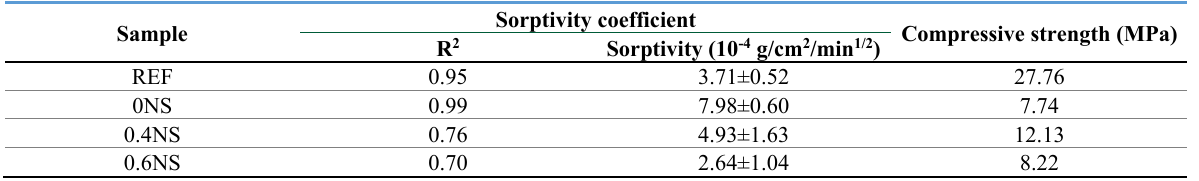
Table 6. Sorptivity coefficient of mortars.